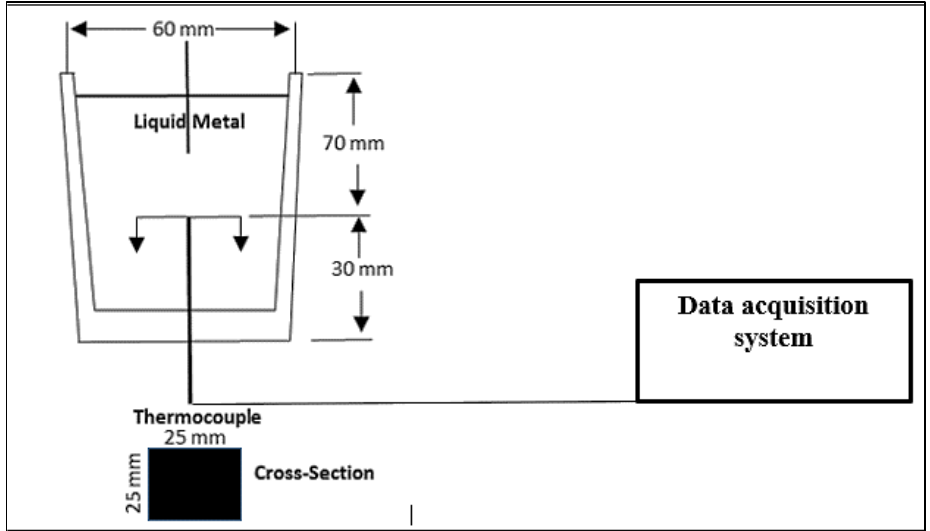
Figure 4. Schematic diagram of the thermal analysis setup used to produce samples solidified at a close-to-equilibrium solidification rate, for the analysis of the precipitated phases. close-to-equilibrium solidification rate, for the analysis of the precipitated